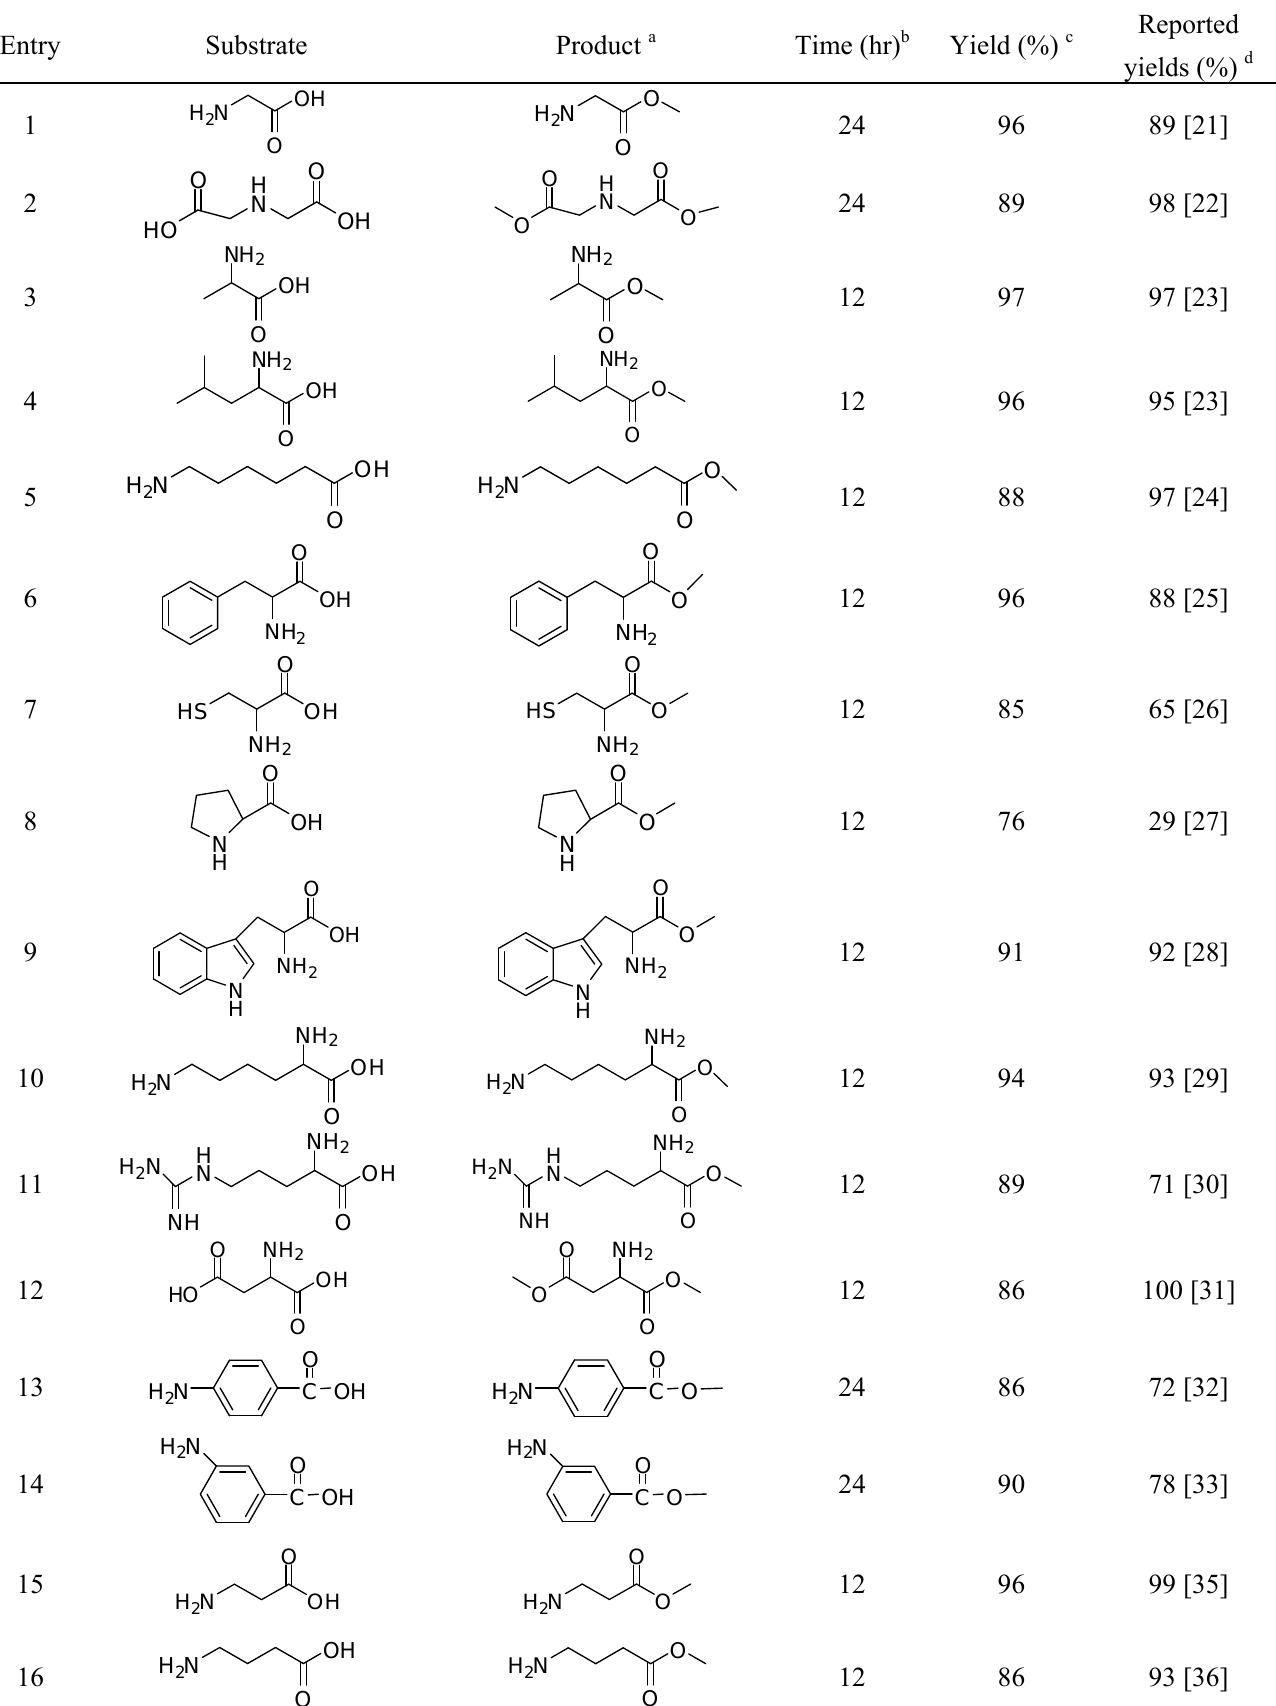
Table 1. Esterification of amino acids with methanol in the presence of TMSCl. Entry Substrate Product a Time (hr) b Yield (%) c